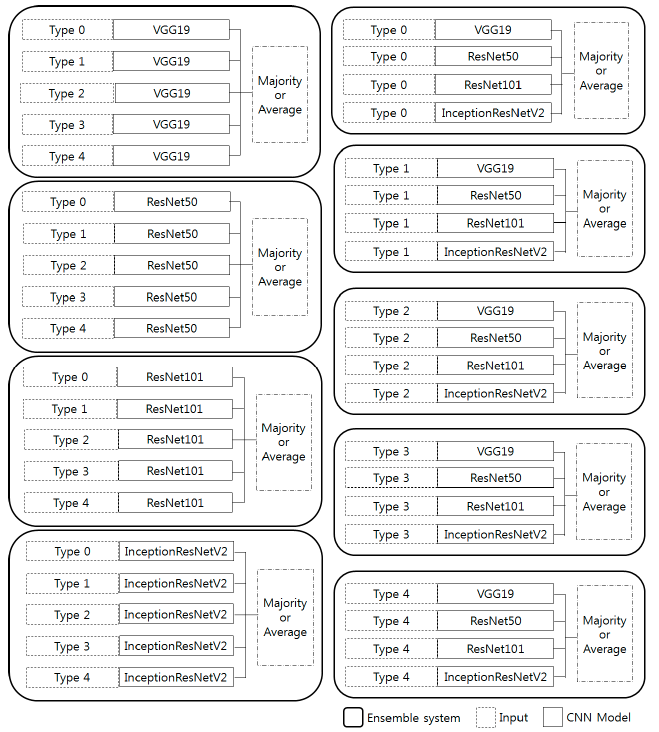
network (CNN) models.